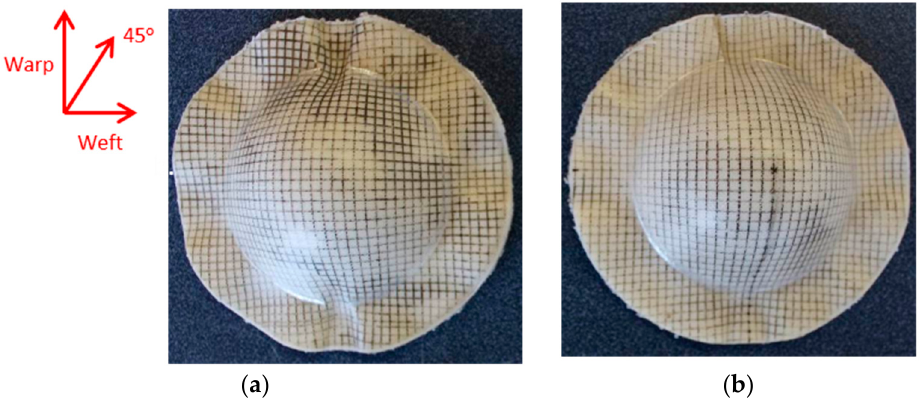
Figure 10 . Bamboo fabric-PLA composite laminates of w/45/ − 45/w layup formed using different blank Figure 10. Bamboo fabric-PLA composite laminates of w/45/ ´ 45/w layup formed using different temperatures. ( a ) w/45/ − 45/w, Blank temperature = 100 °C, Die temperature = 130 °C, Forming rate = blank temperatures. ( a ) w/45/ ´ 45/w, Blank temperature = 100 ˝ C, Die temperature = 130 ˝ C, Forming 60 mm/min, Blank size = 90 mm; ( b ) w/45/ − 45/w, Blank temperature = 130 °C, Die temperature = 130 rate = 60 mm/min, Blank size = 90 mm; ( b ) w/45/ ´ 45/w, Blank temperature = 130 ˝ C, Die temperature °C, Forming, rate = 60 mm/min, Blank size = 90 mm. = 130 ˝ C, Forming, rate = 60 mm/min, Blank size = 90